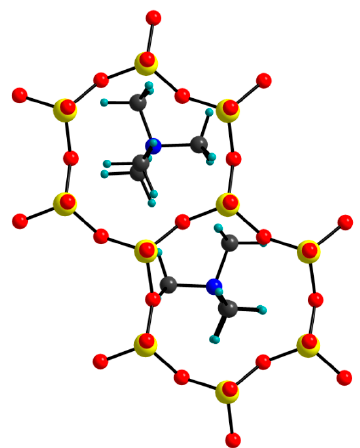
Figure 6. The position of TMA cation in the interlayer space of hectorite: ( a ) b view; ( b ) c * view. The mutual configuration of the two TMA cations in the optimized TMA-H structure (L model) is presented in Figure 7. Neighboring cations are rotated in order to avoid unrealistically close contacts. N ··· O basal distances vary in the range of 3.84–4.71 Å. Both cations are anchored into the silicate tetrahedral sheets on both sides and in this way cross-link the interlayer space through hydrogen bonds discussed in the previous paragraph (Figure 4a).